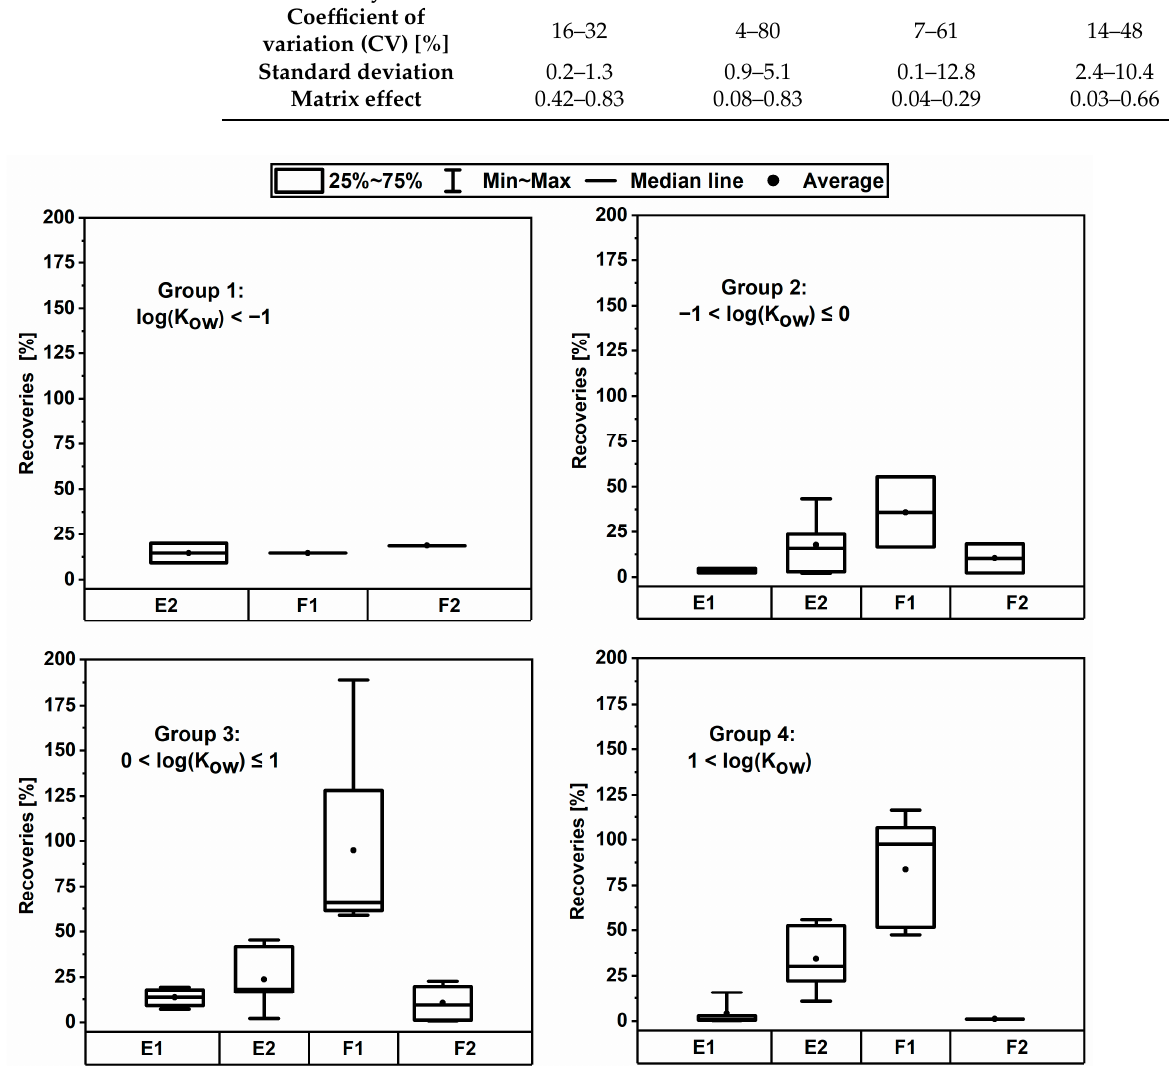
Figure 3. The boxplots for the recoveries of protocols E and F with two consecutive steps indicated as 1 and 2. ABs were regrouped after their log(Kow) values in the four